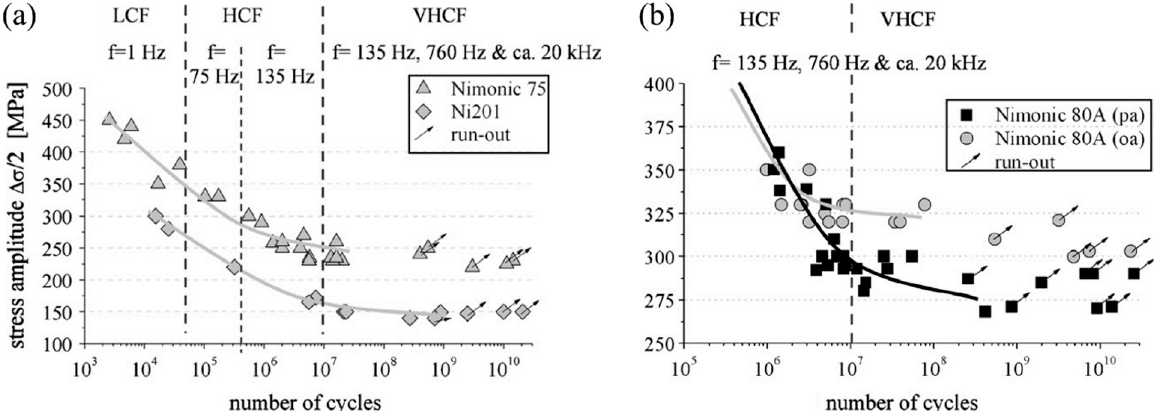
Figure 14. Fatigue data of different Ni ‐ based alloys obtained with servo ‐ hydraulic, resonance electromechanical and ultrasonic fatigue testing; ( a ) pure nickel (Ni201), Nimonic 75 and ( b ) peak ‐ aged (pa) and overaged (oa) Nimonic 80A; reprinted with permission from Elsevier [80].